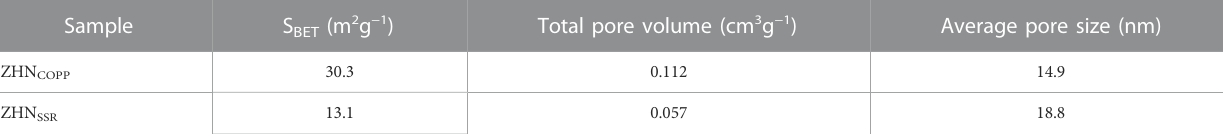
TABLE 1 Textural characteristics of the two ZHN samples. Sample